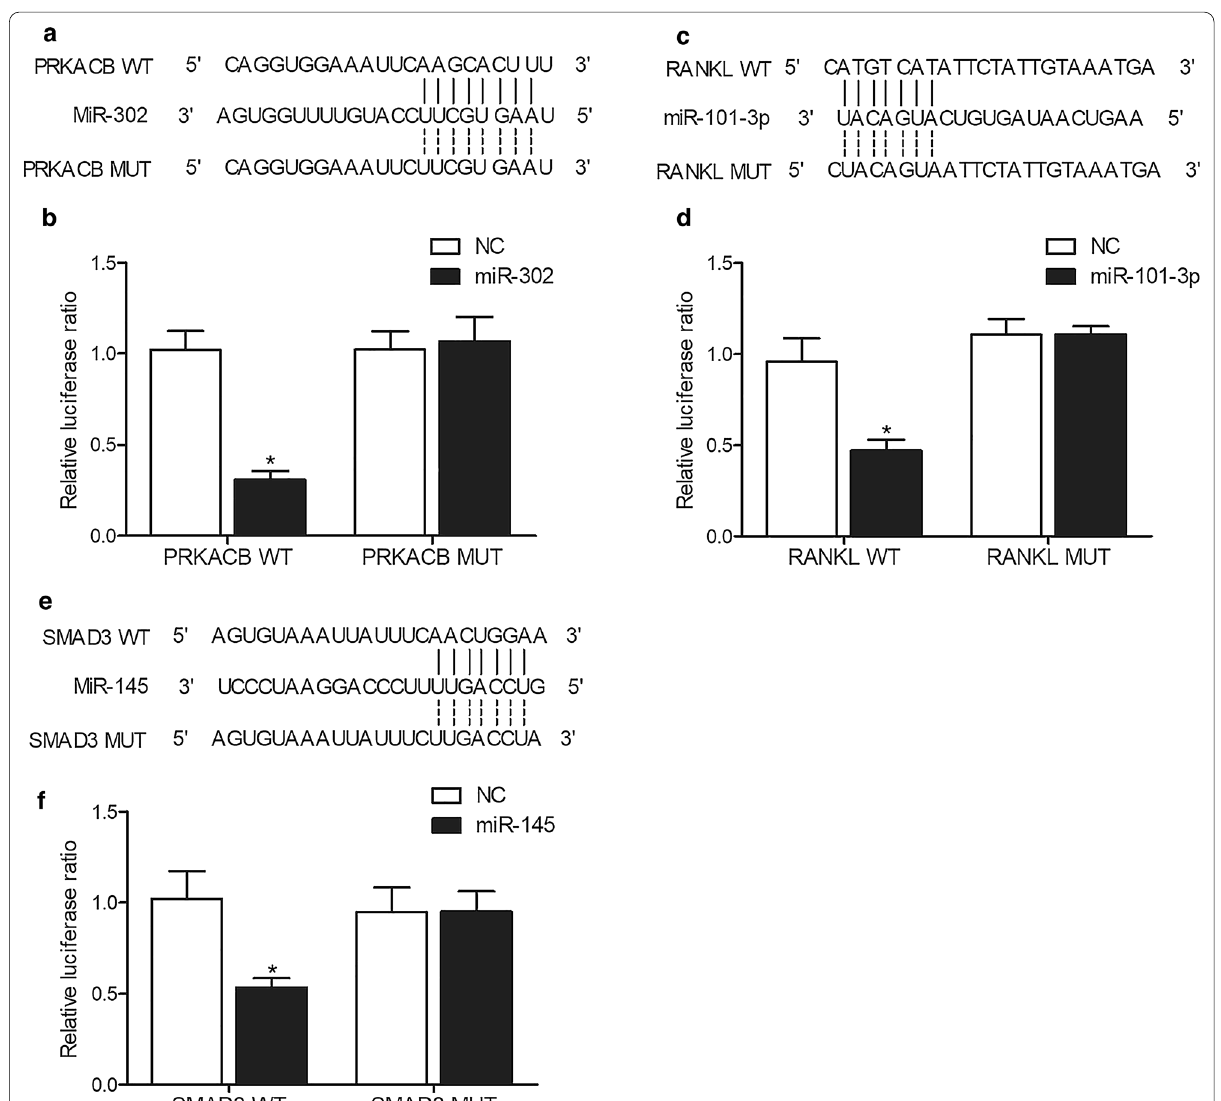
Fig. 5 MiR‑302, miR‑101 and miR‑145 suppressed the expression of PRKACB, RANKL and SMAD3 through binding to their 3 ′ UTR, respectively (*P value < 0.05 vs. NC group). a Sequence analysis indicated potential binding of miR‑302 to the 3 ′ UTR of PRKACB. b The luciferase activity of wild type PRKACB vector was suppressed by miR‑302 in human osteoclast precursor cells. c Sequence analysis indicated potential binding of miR‑101 to the 3 ′ UTR of RANKL. d The luciferase activity of wild type RANKL vector was suppressed by miR‑101 in human osteoclast precursor cells. e Sequence analysis indicated potential binding of miR‑145 to the 3 ′ UTR of SMAD3. f The luciferase activity of wild type SMAD3 vector was suppressed by miR‑145 in human osteoclast precursor